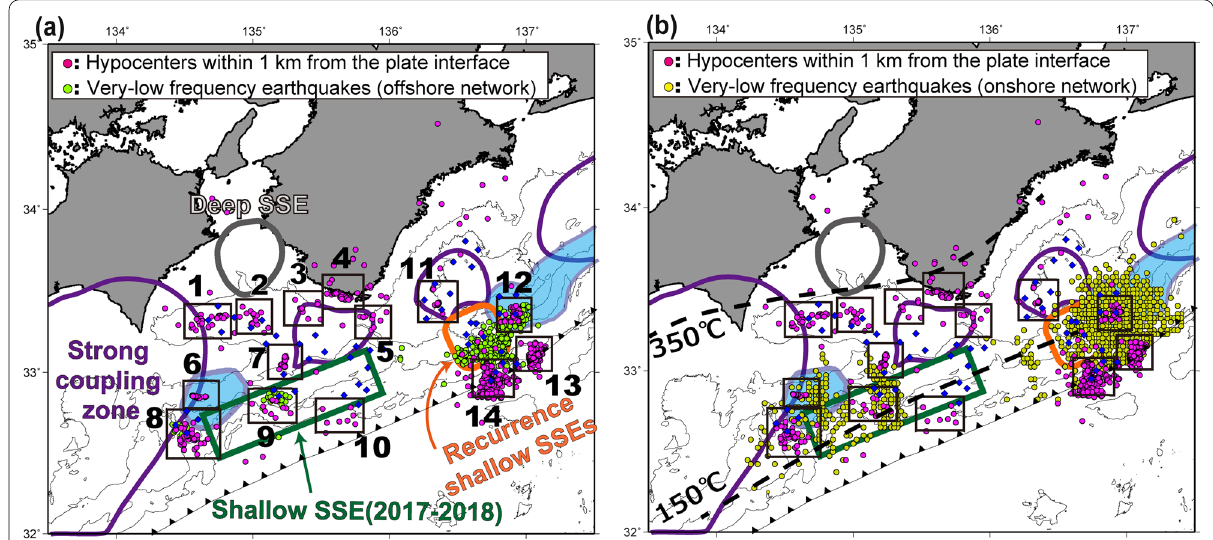
Fig. 11 The location of the active areas for interplate seismicity and very-low-frequency earthquakes (VLFEs). Relocated hypocenters within the 1 km from the plate interface are shown by pink circles. a Numbers from 1 to 14 reflect area code. VLFEs estimated by using the offshore seismic network are shown by green circles (Sugioka et al. 2012; Nakano et al. 2018a; Toh et al. 2020; Yamamoto et al. 2022). Location of the subducted seamount off Muroto and the Paleo-Zenith Ridge is shown by light-blue areas. b VLFEs estimated by using onshore seismic network are shown by yellow circles (Takemura et al. 2019). Other symbols are the same as in Fig.